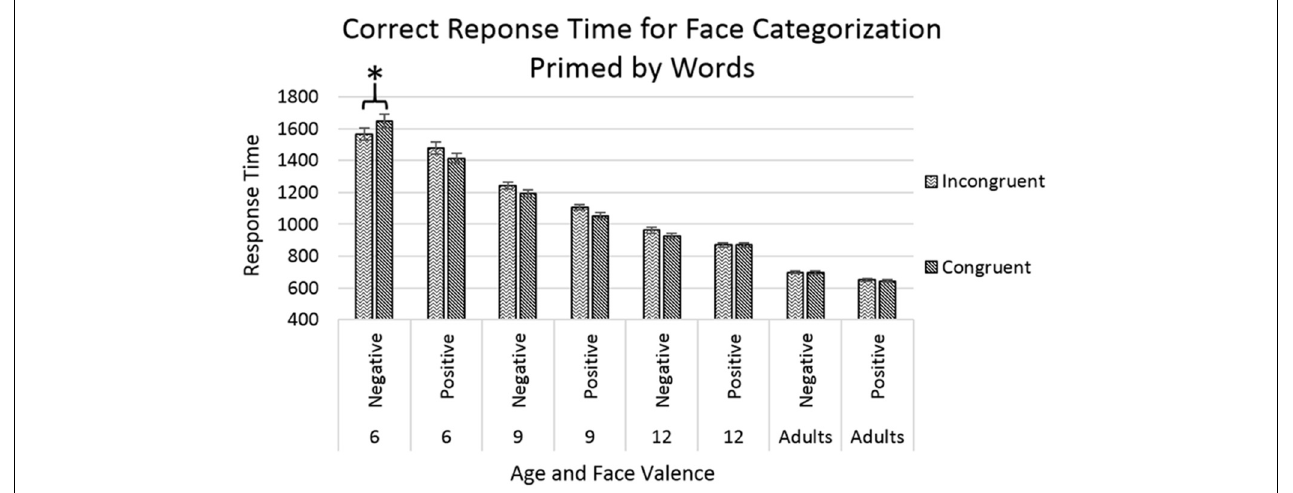
FIGURE 3 | Response time for correct trials categorizing face targets after priming by emotion words. Error bars represent standard error, and a star indicates a significance level of p < 0.05.